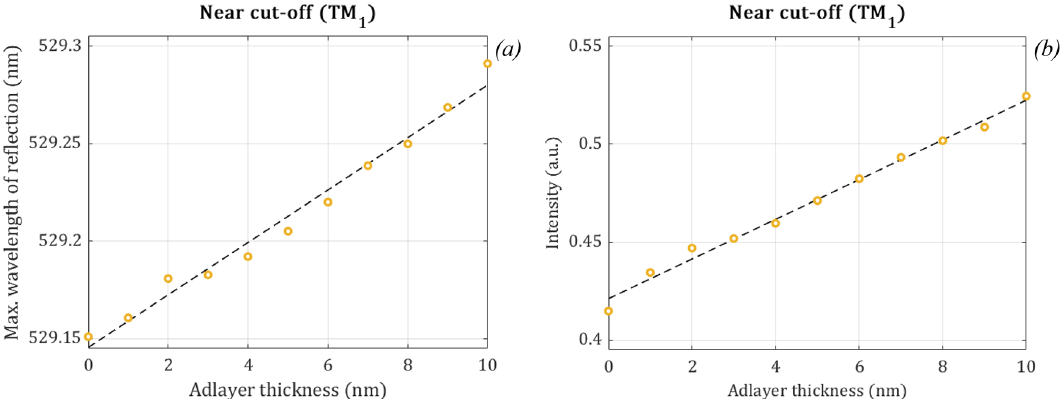
Figure 12. The maximum wavelengths ( a ) and the intensity ( b ) of the reflection peaks for the near cut-off mode in function of the additional biological layer thickness. We also fitted a line on the simulated data (black dashed lines). We used n C = 1.33 as a standard cover refractive index of the puffer solution for biological measurements and d F = 185 nm as before for the main experiments with incident angle of 26°. We changed the thickness (d A ) of an additional biological layer from 0 to 10 nm on the surface of the sensor with refractive index n A = 1.45, which refractive index value is common for biological